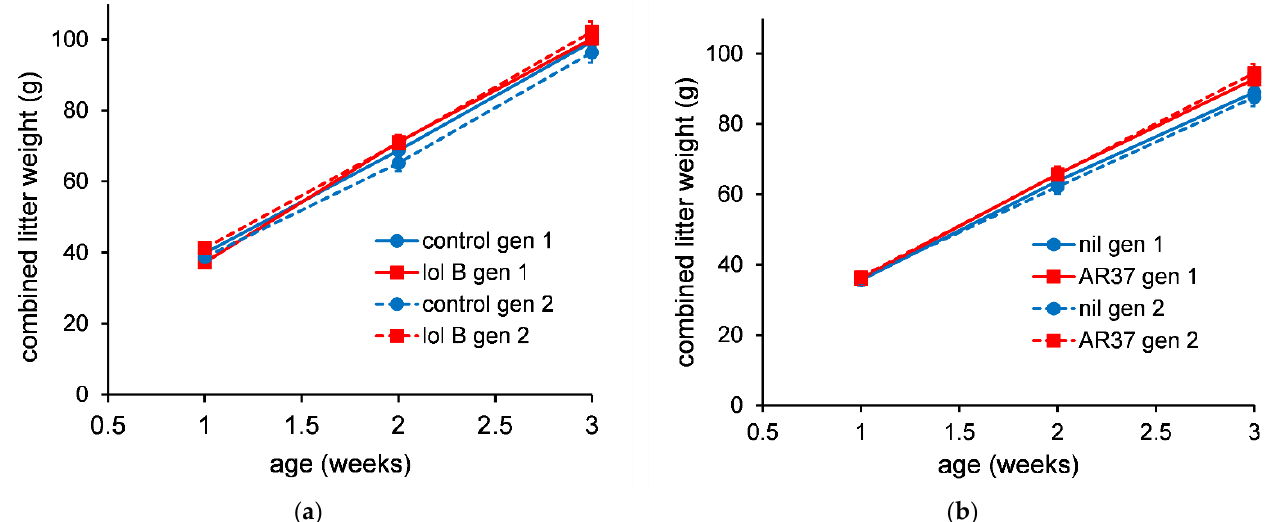
Figure 4. The combined litter weights ( n = 5) for two generations fed: ( a ) control or diet containing lolitrem B (1.06 ppm); ( b ) diet containing nil or AR37 endophyte-infected seed (30% seed). The error bars are the standard error obtained from the fitted model.